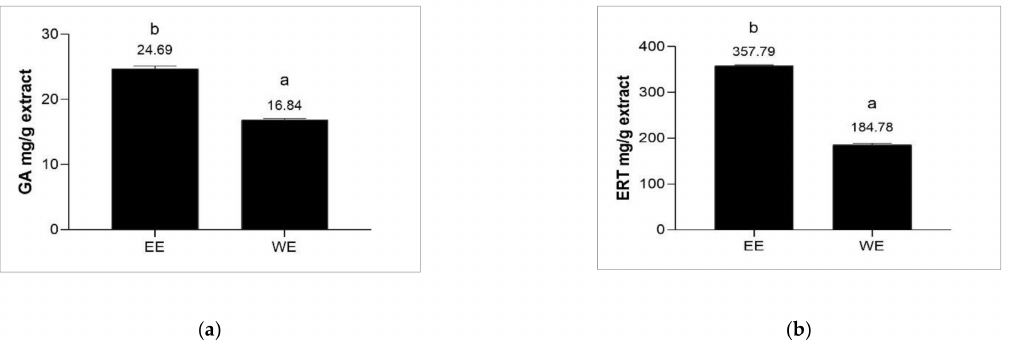
Figure 3. ( a ) Gallic acid (GA) and ( b ) Ergothioneine (ERT) contents of the brown A. bisporus ethanol extract (EE) and the brown A. bisporus water extract (WE). Different letters above the bars indicate statistically significant differences. Multiple comparisons of means are performed using Tukey’s test at the 0.05 significance